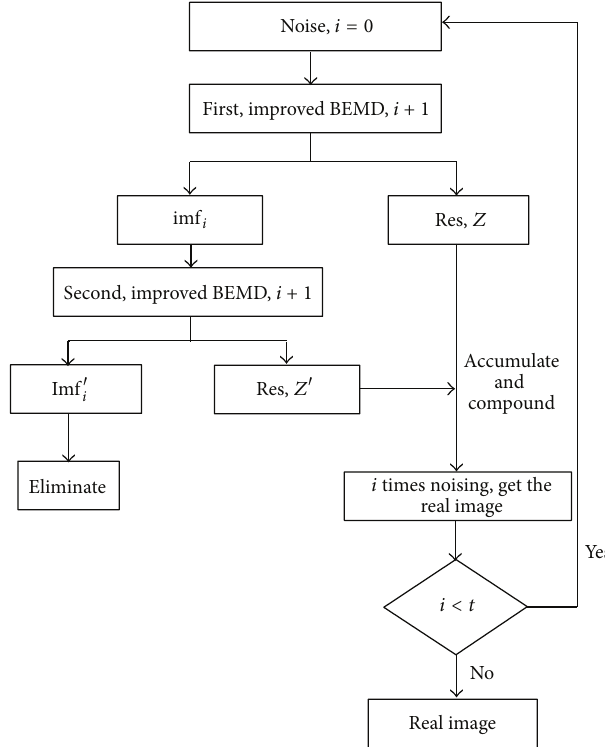
Figure 1: Flowchart of image denoising by the modified BEMD